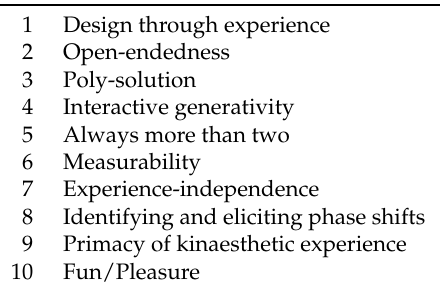
Table 1. The ten design features of ICI